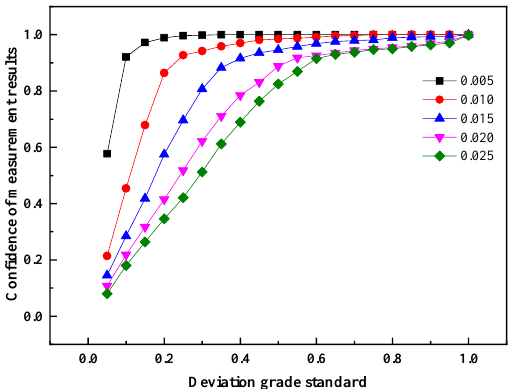
Figure 19. Relationship between deviation grade standard and confidence of measurement results under different relative standard deviations of temperature at velocity 1.35 m/s.